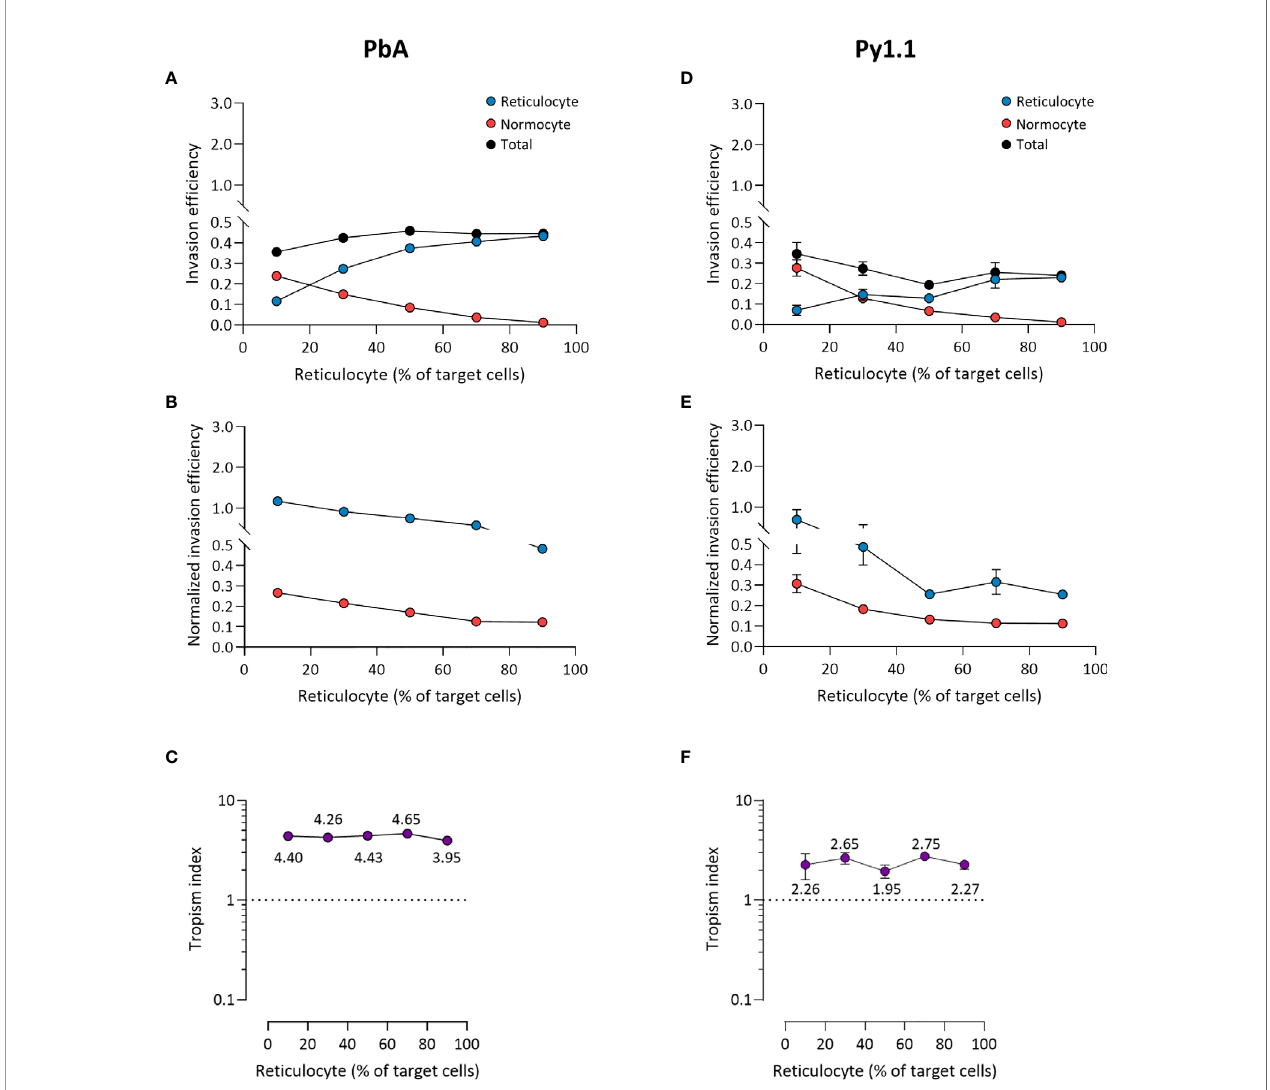
FIGURE 5 | Ex vivo tropism of P. berghei ANKA (A – C) and P. yoelii 17X1.1 (D – F) at variable reticulocyte:normocyte ratios. (A, D) Reticulocyte (blue) and normocyte (red) invasion ef fi ciencies (see Materials and Methods for calculation) were compared at fi ve different erythrocyte ratios, 10:90, 30:70, 50:50, 70:30, 90:10 reticulocyte:normocyte. Total invasion ef fi ciency (black) is the sum of reticulocyte and normocyte invasions. (B, E) Reticulocyte and normocyte invasion ef fi ciencies were normalized to their respective population frequencies (see Materials and Methods ). (C, F) Tropism indices were calculated from the ratio of normalized reticulocyte invasion ef fi ciency to the normalized normocyte invasion ef fi ciency. Mean tropism indices are also shown. Dotted lines at tropism index = 1 represent mixed tropism. All error bars represent standard deviation. n = 5 technical replicates, for each